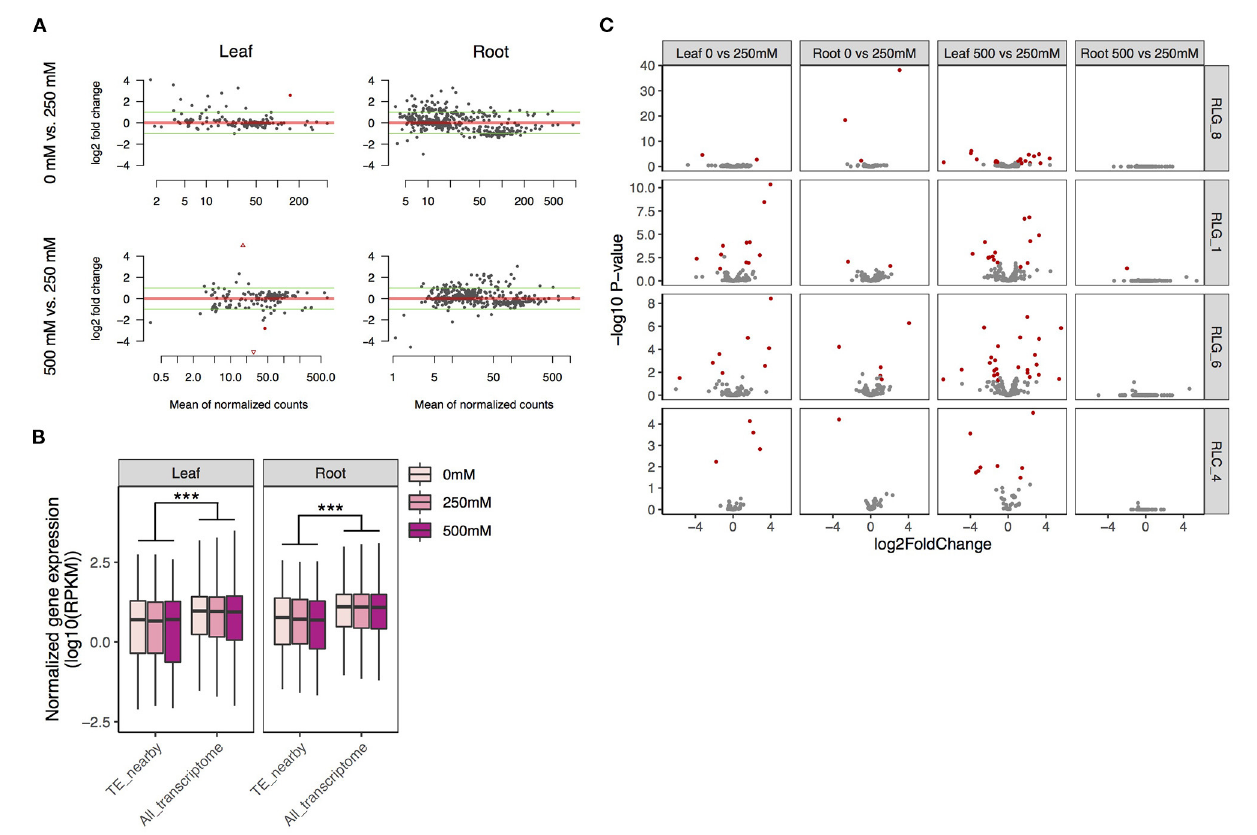
FIGURE 5 | Expression patterns of TEs and their flanking genes under salt treatments in S. alba . (A) Fold changes of the expression levels of intact Gypsy and Copia retrotransposons across salt treatments (the upper: 0mM vs. 250mM NaCl, the lower: 250mM vs. 500mM NaCl). (B) Expression levels of genes neighboring copies of the four most abundant LTR retrotransposon families in comparison with the whole transcriptome. (C) Fold expression change of genes next to copies of the four most abundant LTR retrotransposon families across salt treatments (the upper: 0mM vs. 250mM NaCl, the lower: 500mM vs 250mM NaCl). Genes with significant mis-expression (FDR < 0.05 and ≥ 2-fold change) between treatments are indicated in red. Significance was determined by the Mann-Whitney U test: *** P <